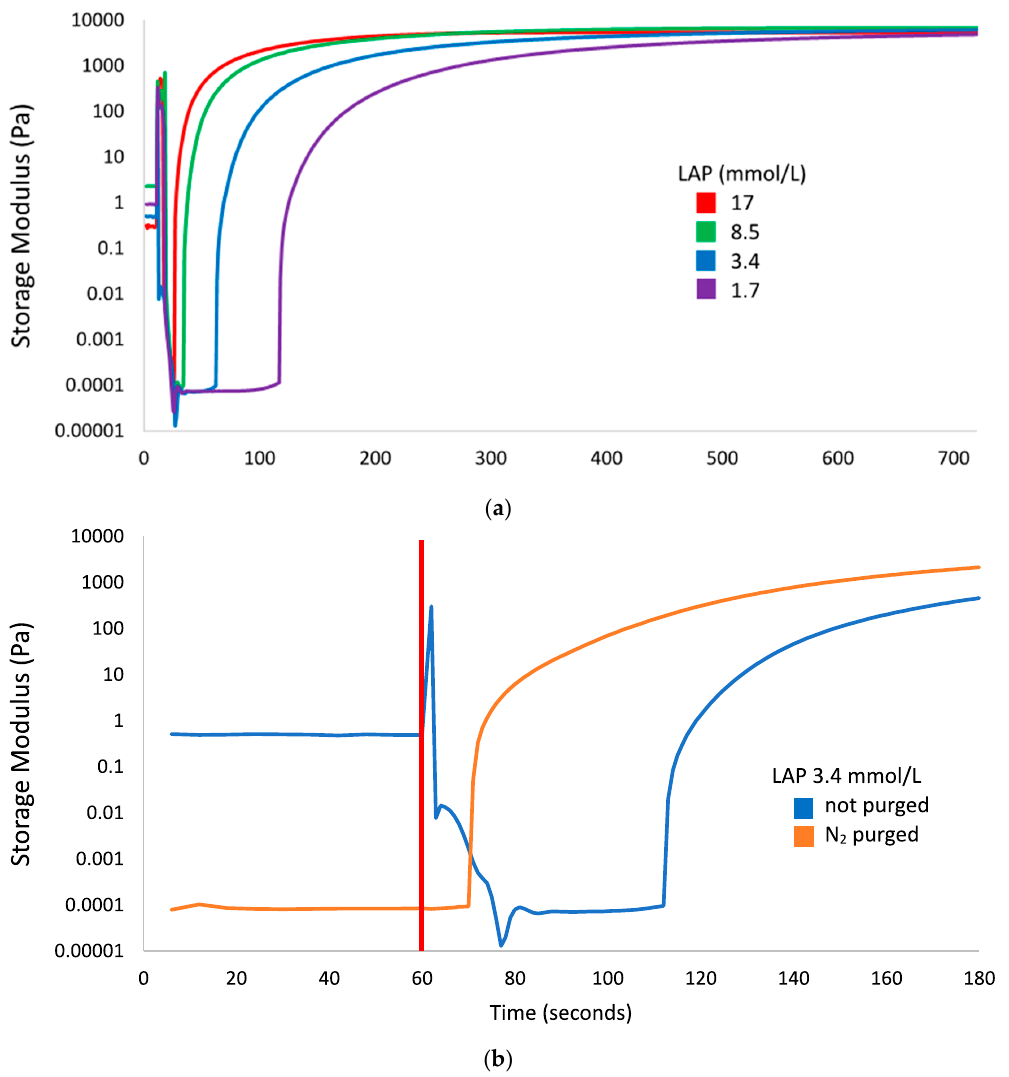
Figure 1. Storage modulus of 10% gelatin methacryloyl (GelMA) with lithium phenyl (2,4,6- trimethylbenzoyl) phosphinate (LAP) photoinitiator tracked by photorheology; the 405 nm light source (3 mW/cm 2 ) was switched on at 60 s for all measurements. ( a ) Crosslinking of GelMA with 17 (red), 8.5 (green), 3.4 (blue), and 1.7 (purple) mmol/L LAP. ( b ) Crosslinking of non-nitrogen-purged (blue) and nitrogen-purged (orange) GelMA with 3.4 mmol/L LAP, with a focus on the time between light exposure and a rise in storage modulus; the red line denotes the start of light